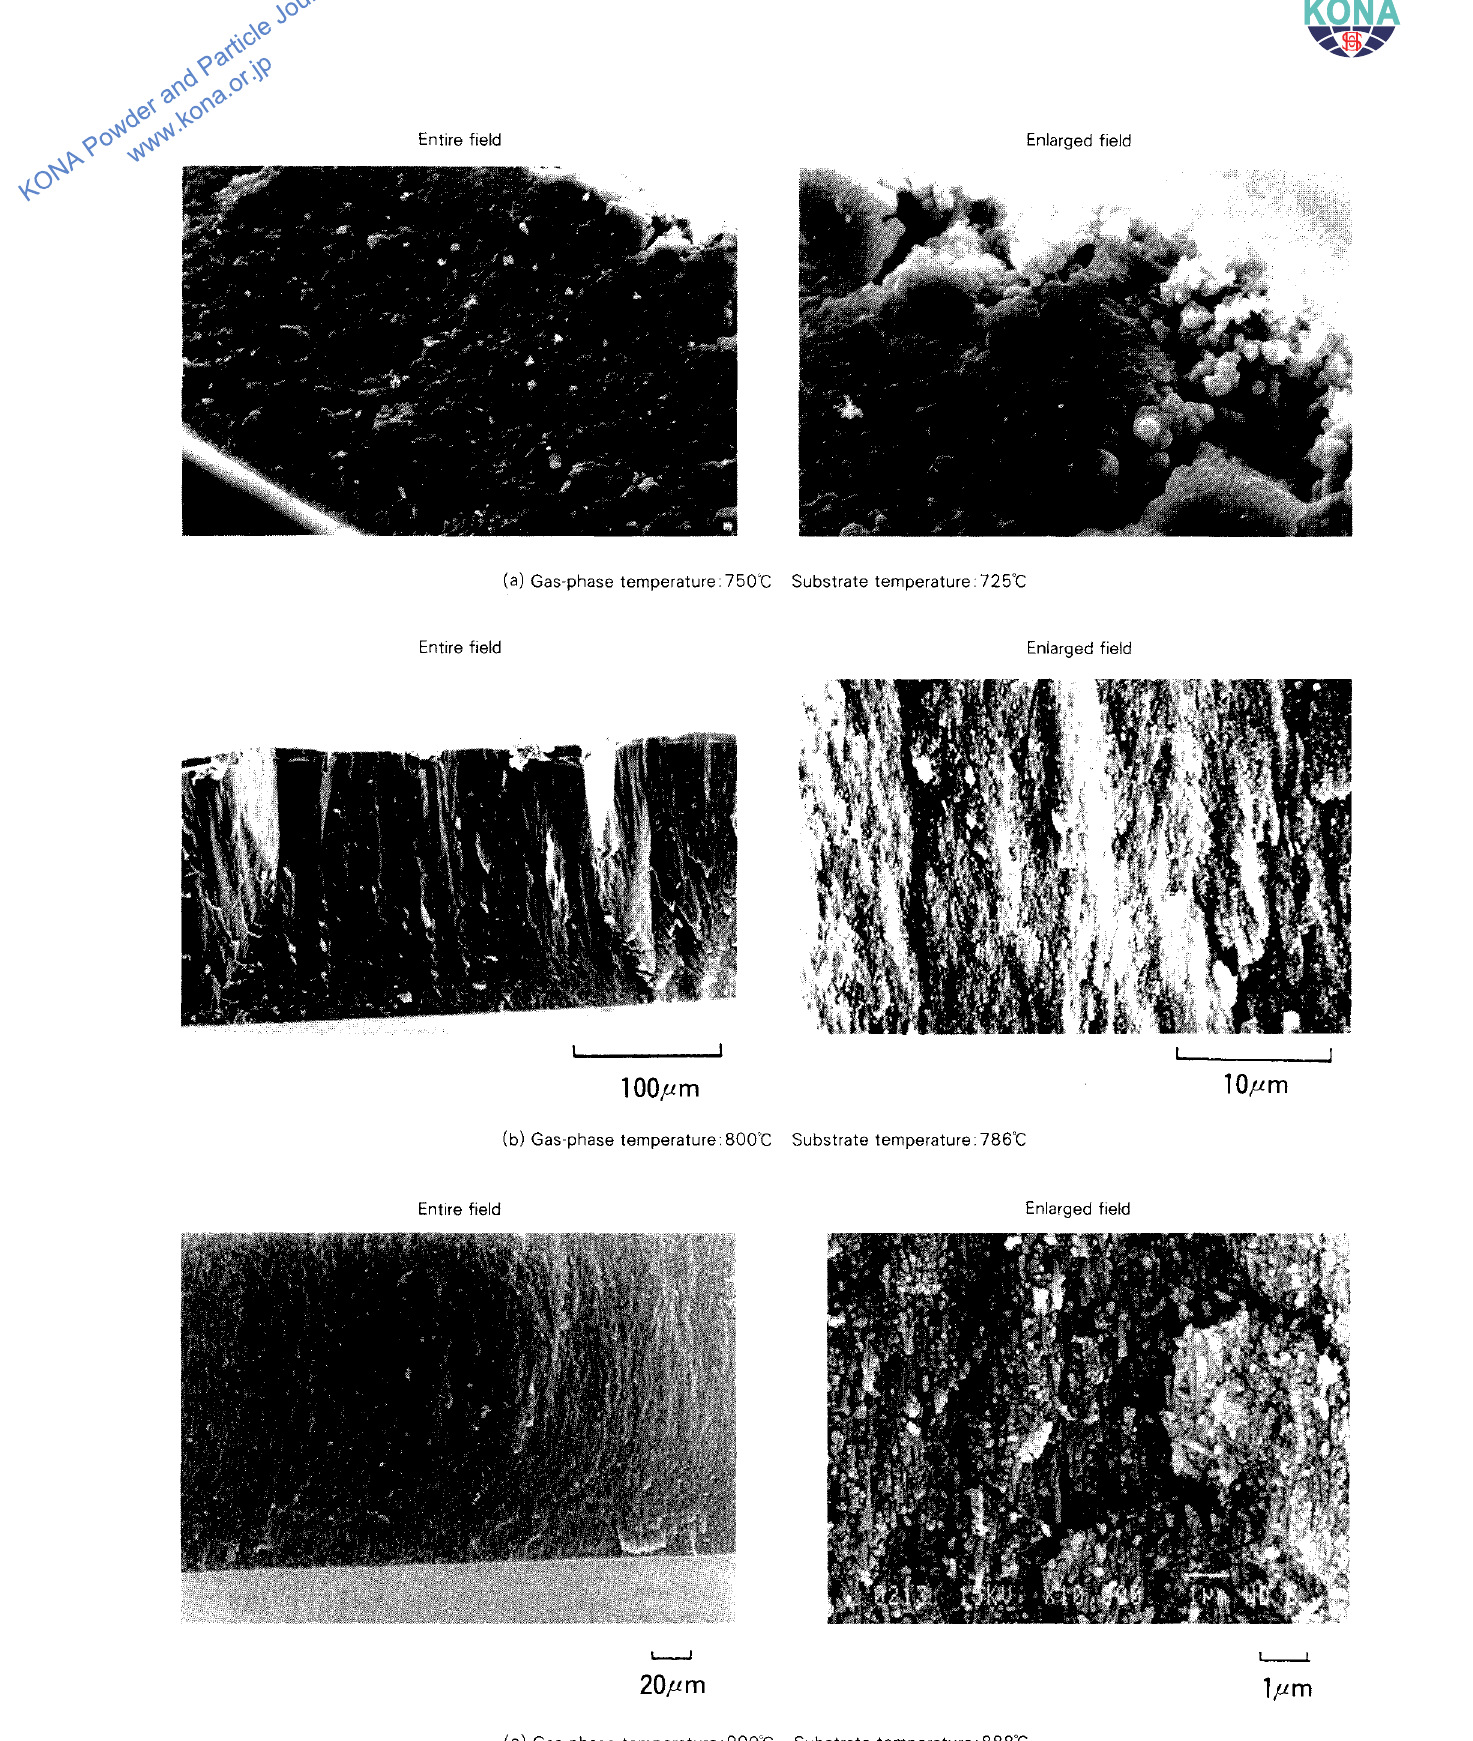
Fig. 9 Examples of dense synthesized AIN films